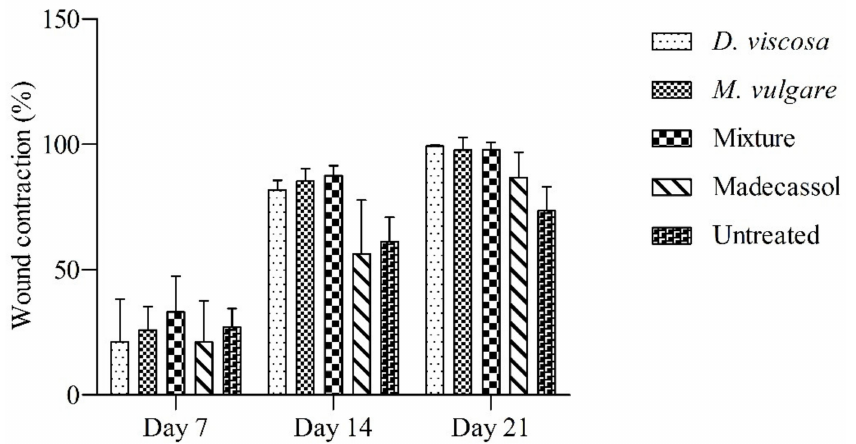
Figure 6. Burn healing effect of D. viscosa , M. vulgare , the mixture applied dermally, the untreated group, and the group treated with Madecassol ® . The size of wounds on the first day of the experiment was used as reference. The data represent the mean ±